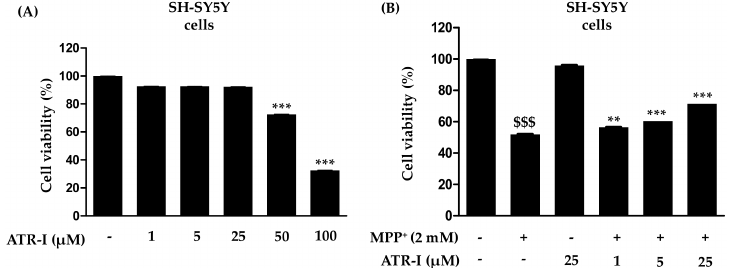
Figure 1. ( A , B ) Effects of atractylenolide-I (ATR-I) on cell viability in SH-SY5Y cells intoxicated with or without 1-methyl-4-phenylpyridinium (MPP + ). The viability of cells was performed as mentioned in the “Material and Method” section. *** p < 0.001 vs. vehicle group. $$$ p < 0.001 vs. vehicle group, and *** p < 0.001, ** p < 0.01 vs. MPP + -treated